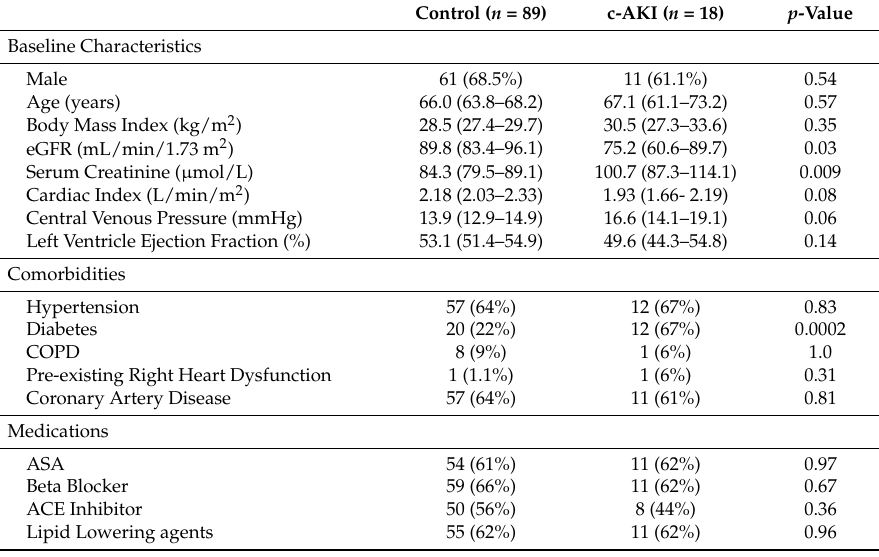
Table 1. Characteristics of patients with congestive acute kidney injury (c-AKI) vs. controls. Control ( n = 89) c-AKI ( n =